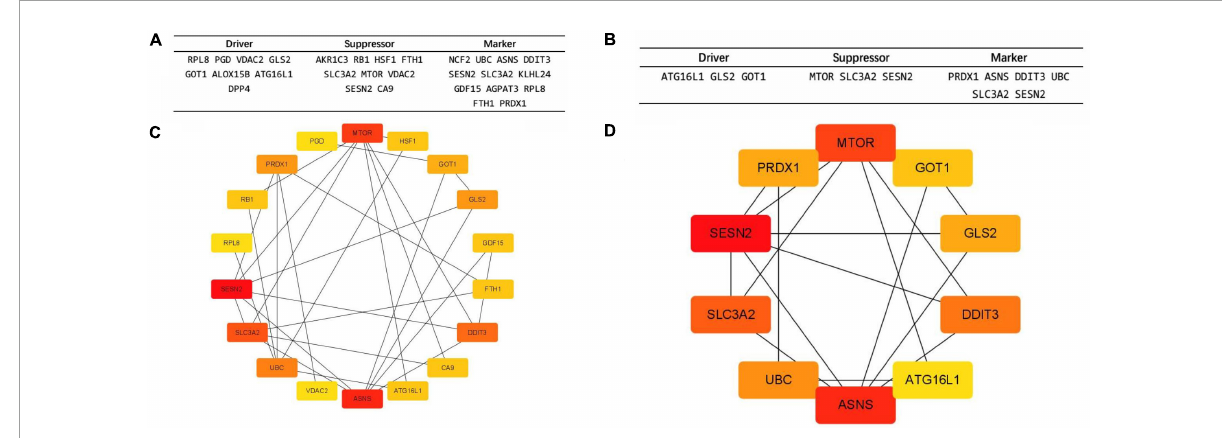
FIGURE2 The protein–protein interaction (PPI) network and 10 hub gene interaction network analyzed using Cytoscape software. (A,C) The 24 Ferroptosis-related DEGs analyzed using STRINGS and Cytohubba (MCC Ranking method). The network includes 18 nodes and 29 edges. (Disconnected nodes are hidden). (B,D) Picking the top 10 rank genes (MCC Ranking method). The network includes 10 nodes and 16 edges. Gene to gene interactions are depicted in the graph as edges between two nodes. The different nodes represent the variation of the degrees from high to low, determined by the degree of interaction.